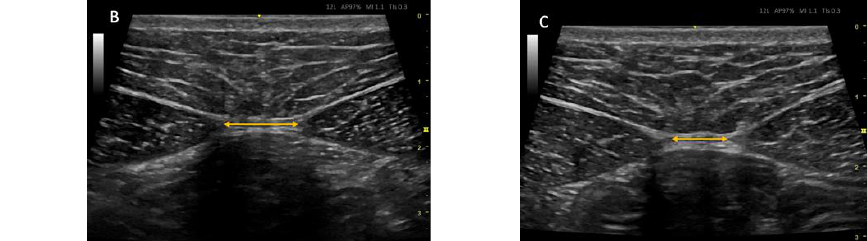
Figure 3. Ultrasonic images of the rectus abdominis (RA). ( A ) at rest and ( B ) during muscle activity. Measurements are taken between the internal borders of the widest area of the muscle belly. An increase in muscle thickness is appreciable during contraction ( B ).